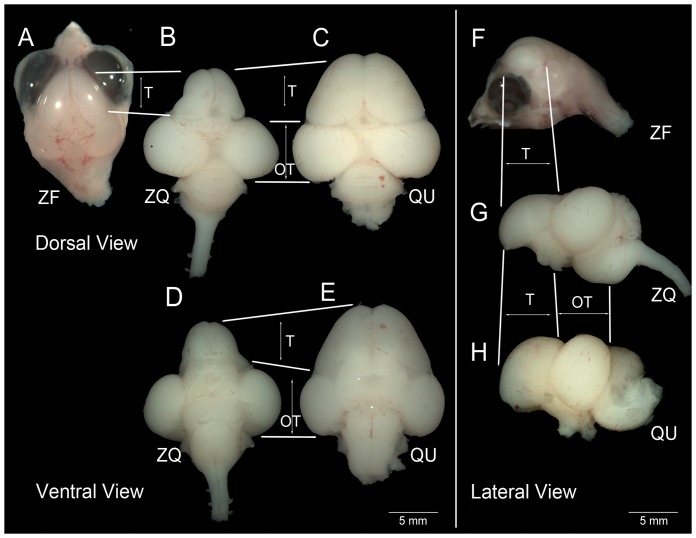
Three views of zebra finch (ZF), chimera (ZQ), and quail (QU) brains at ED12.Dorsal (A–C), ventral (D–E), and lateral (F–G) views of whole brain morphology of each of the three groups, showing that the ZQ chimera is intact and well connected between the grafted forebrain and host brain. The zebra finch brain was left inside the thin skull, as removing it as this age is very delicate and the brain was easily destroyed by adhering to the thin skull. This was not the case for the quail and chimera heads. Lines designate subdivision boundaries. T, telencephalon; OT, optic tectum.